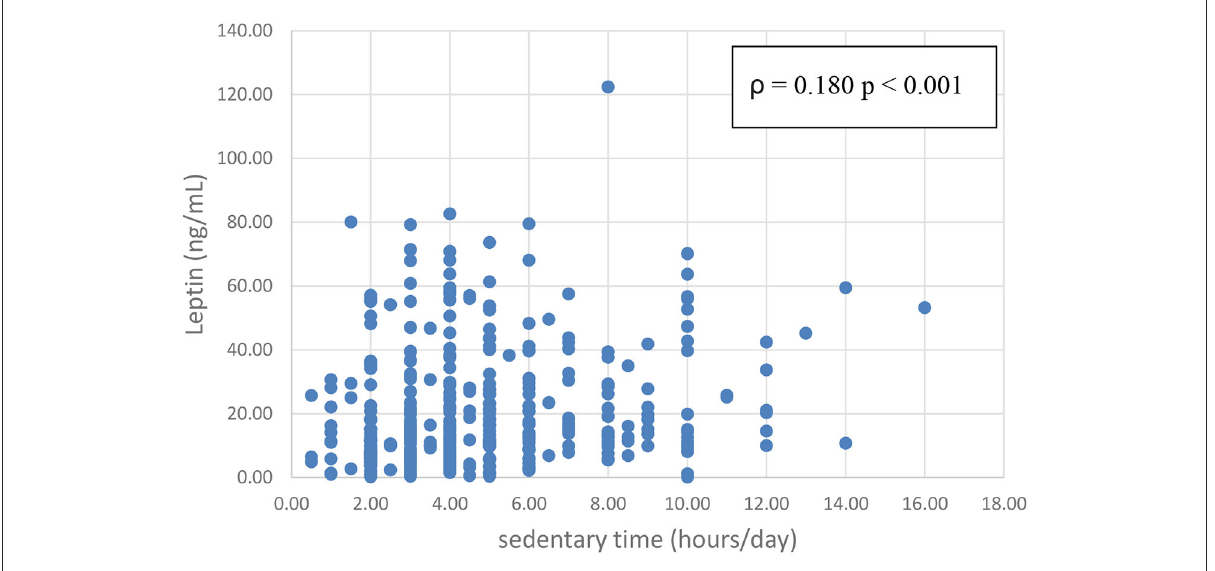
FIGURE1 The scatterplot shows the relationship between sedentary time and leptin.